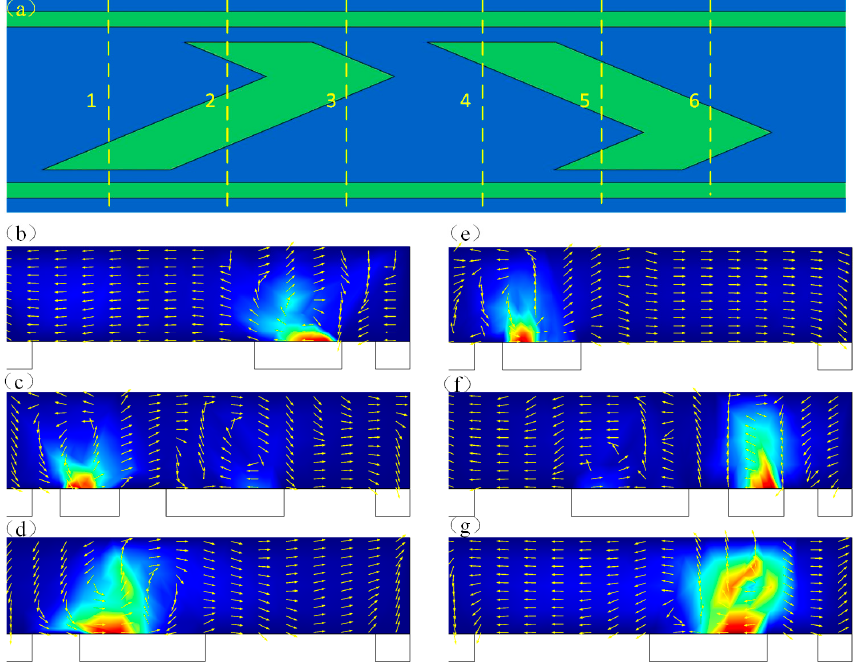
Figure 3. The fluid microstream at different cross section. ( a ) the definition of cross section 1–6; ( b – d ) the fluid motions on the left herringbone floating electrode at the cross section 1–3; ( e – g ) the fluid flow on the right herringbone floating electrode at the cross section 4–6.